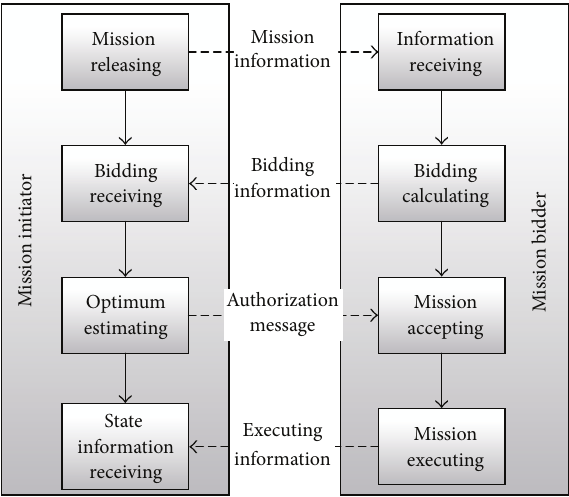
Figure 6: Float of the